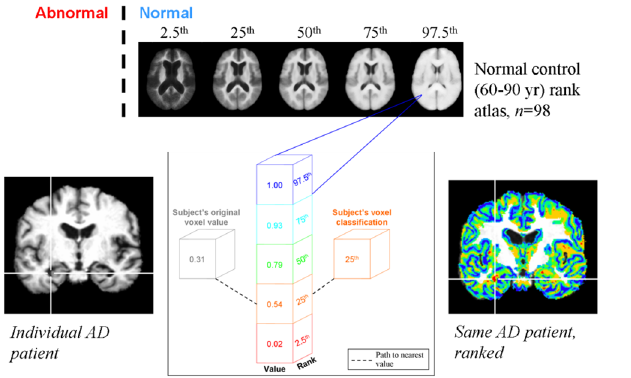
Fig 5. Voxel — based assessment of brain structure with a normal reference atlas. The subject's original voxel value is compared to each of the atlas percentile rank values and is then assigned the rank to which its value is